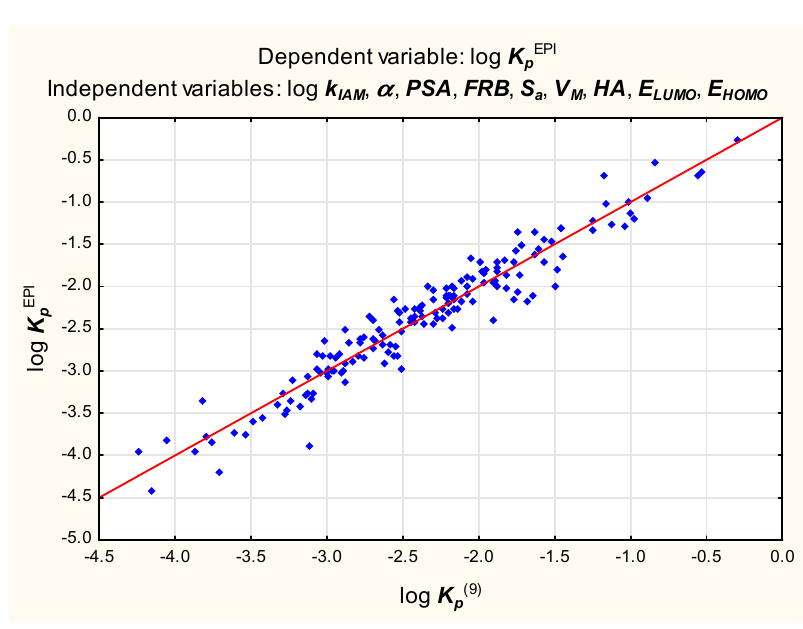
Figure 1. Equation (9)—reference vs. predicted log K p values.